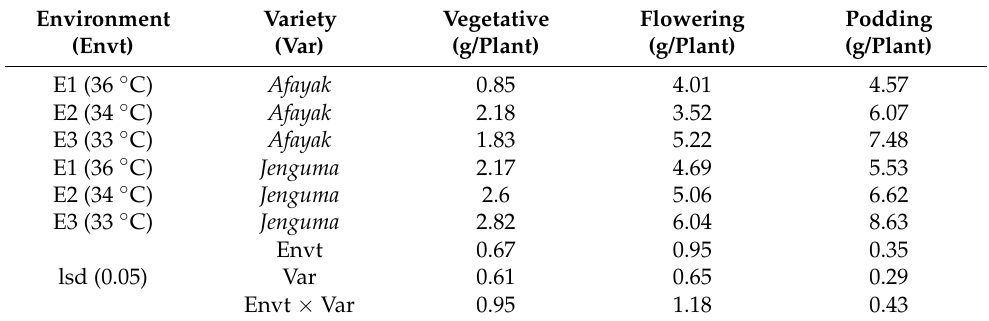
Table 2. Effect of environment on total dry biomass weight (TDW) at the vegetative and flowering stages.